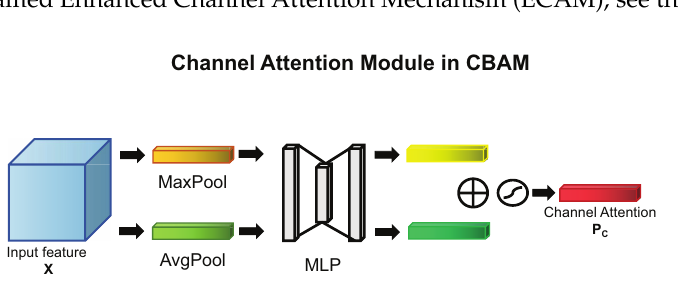
Figure 7. The channel attention mechanism used in CBAM [17].